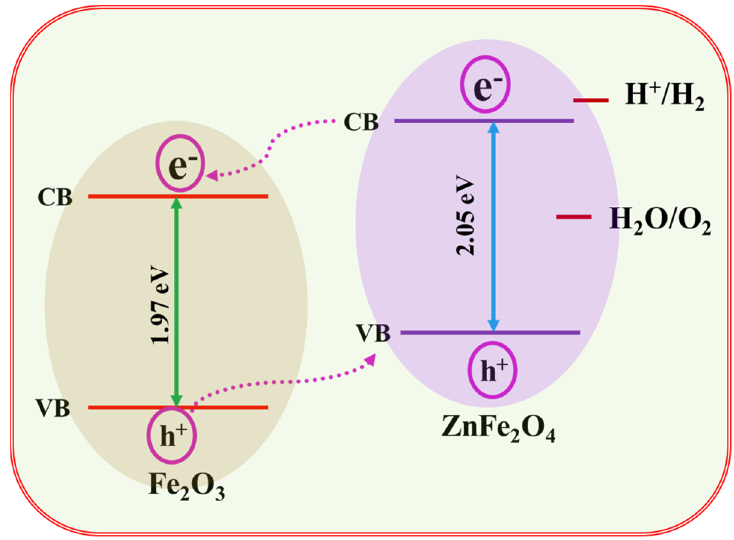
Figure 9. The schematic energy diagram of the heterostructure.